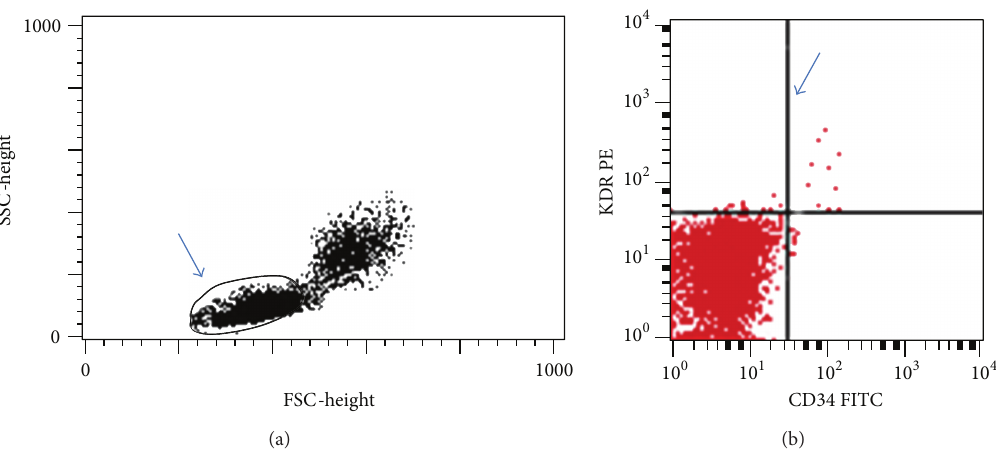
Figure 1: Flow cytometry analysis of CD34+KDR+cells. Representative flow cytometry plots obtained from a healthy control is shown. (a) Forward scatter (FSC), and side scatter (SSC) with lymphocytes gate are indicated. (b) Double fluorescence with PE-labeled KDR and FITC- labeled CD34 antibodies. In top right quadrant CD34/KDR double-positive cells are indicated. Quadrants were set on the basis of isotype